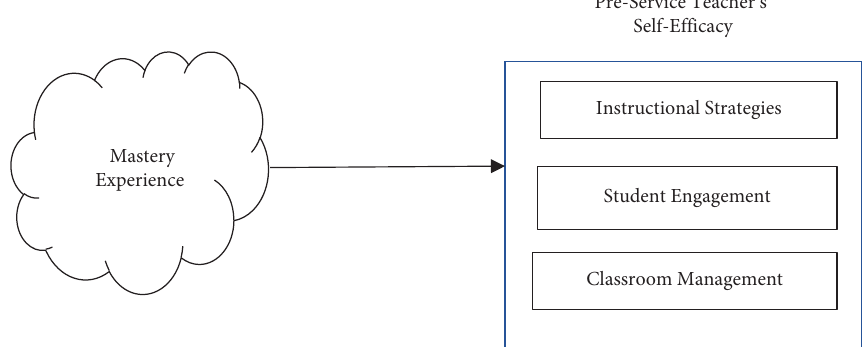
Figure 1: Conceptual framework of the study (source: adapted from Tschannen-Moran and Hoy [33] and Bandura